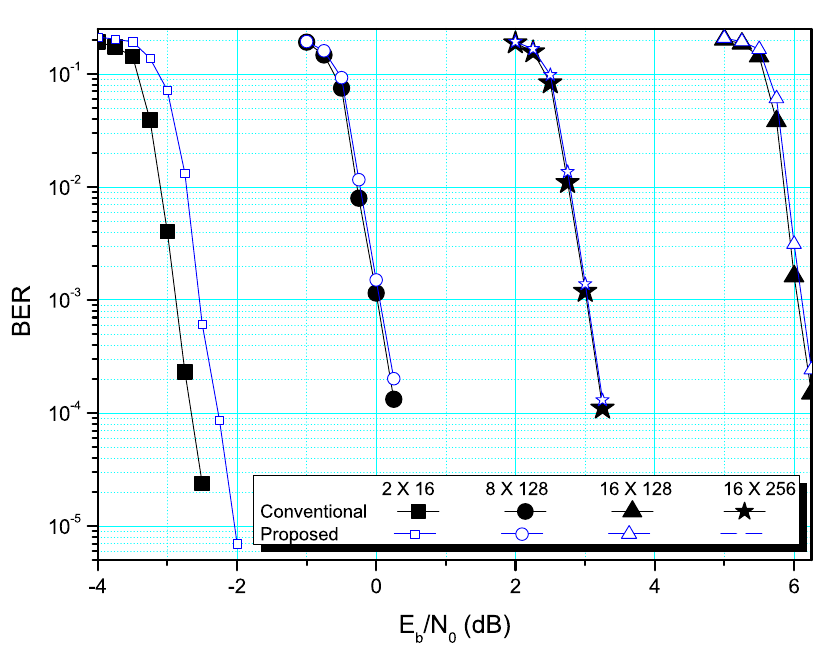
Figure 4. BER performance comparisons with various numbers of antennas when ( η , l ) = ( 4,2 )